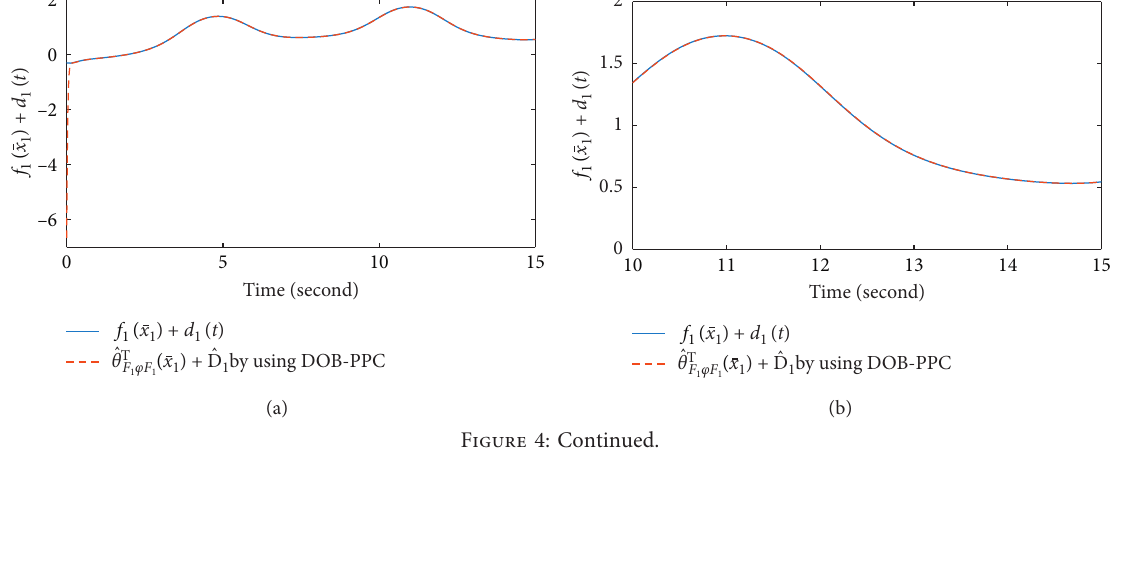
( x ) + d ( t ) by using T- 2 2 2